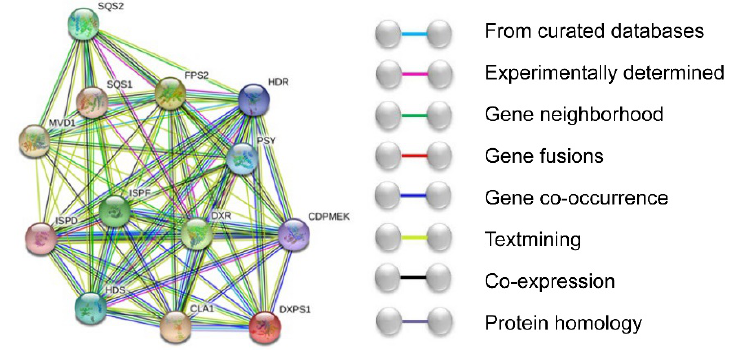
Figure 6. The ZbDXS and ZbFPS protein functional connection network.